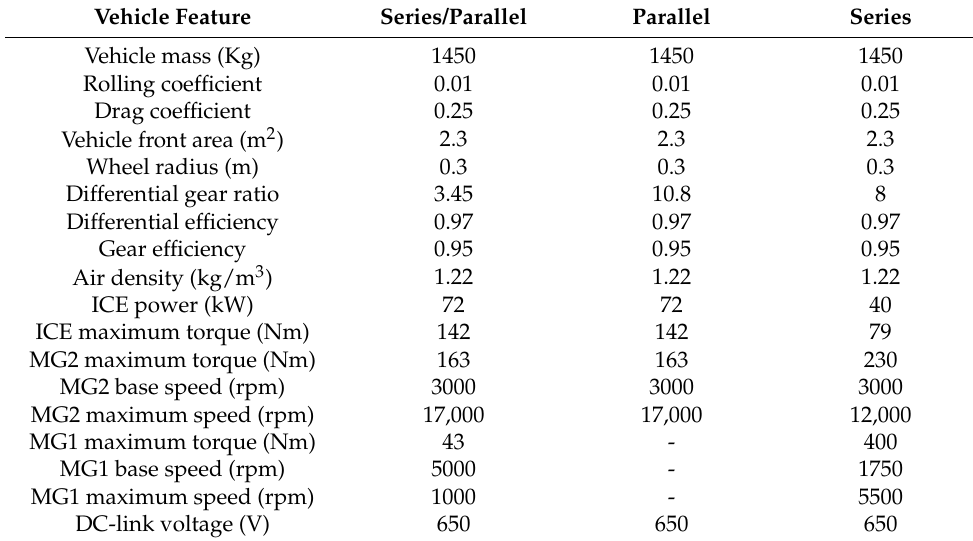
Table 2. Vehicle